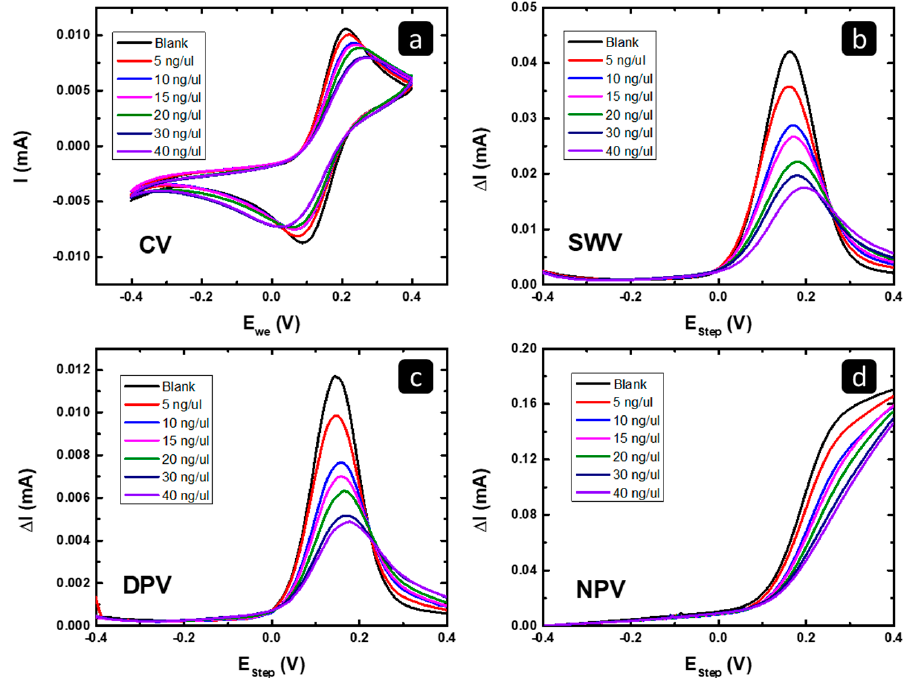
Figure 8. The electrochemical responses of the gold SPE before and after depositing different amounts of the isolated exosomal RNA from MCF7/ADR using ( a ) CV, ( b ) SWV, ( c ) DPV, and ( d ) NPV.